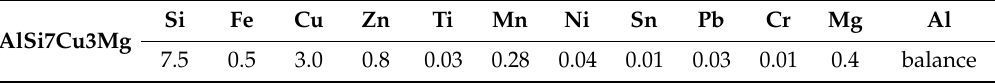
Table 1. Chemical composition of the investigated alloy (%